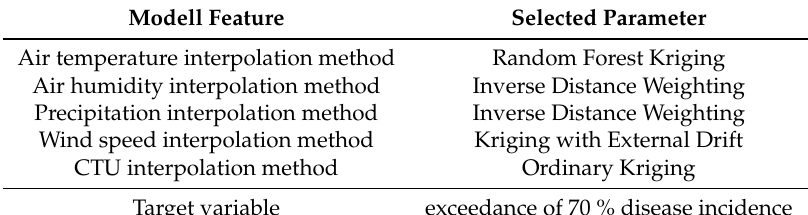
Table 1. Overview of the regionalisation methods applied (justification in the results) and the variables